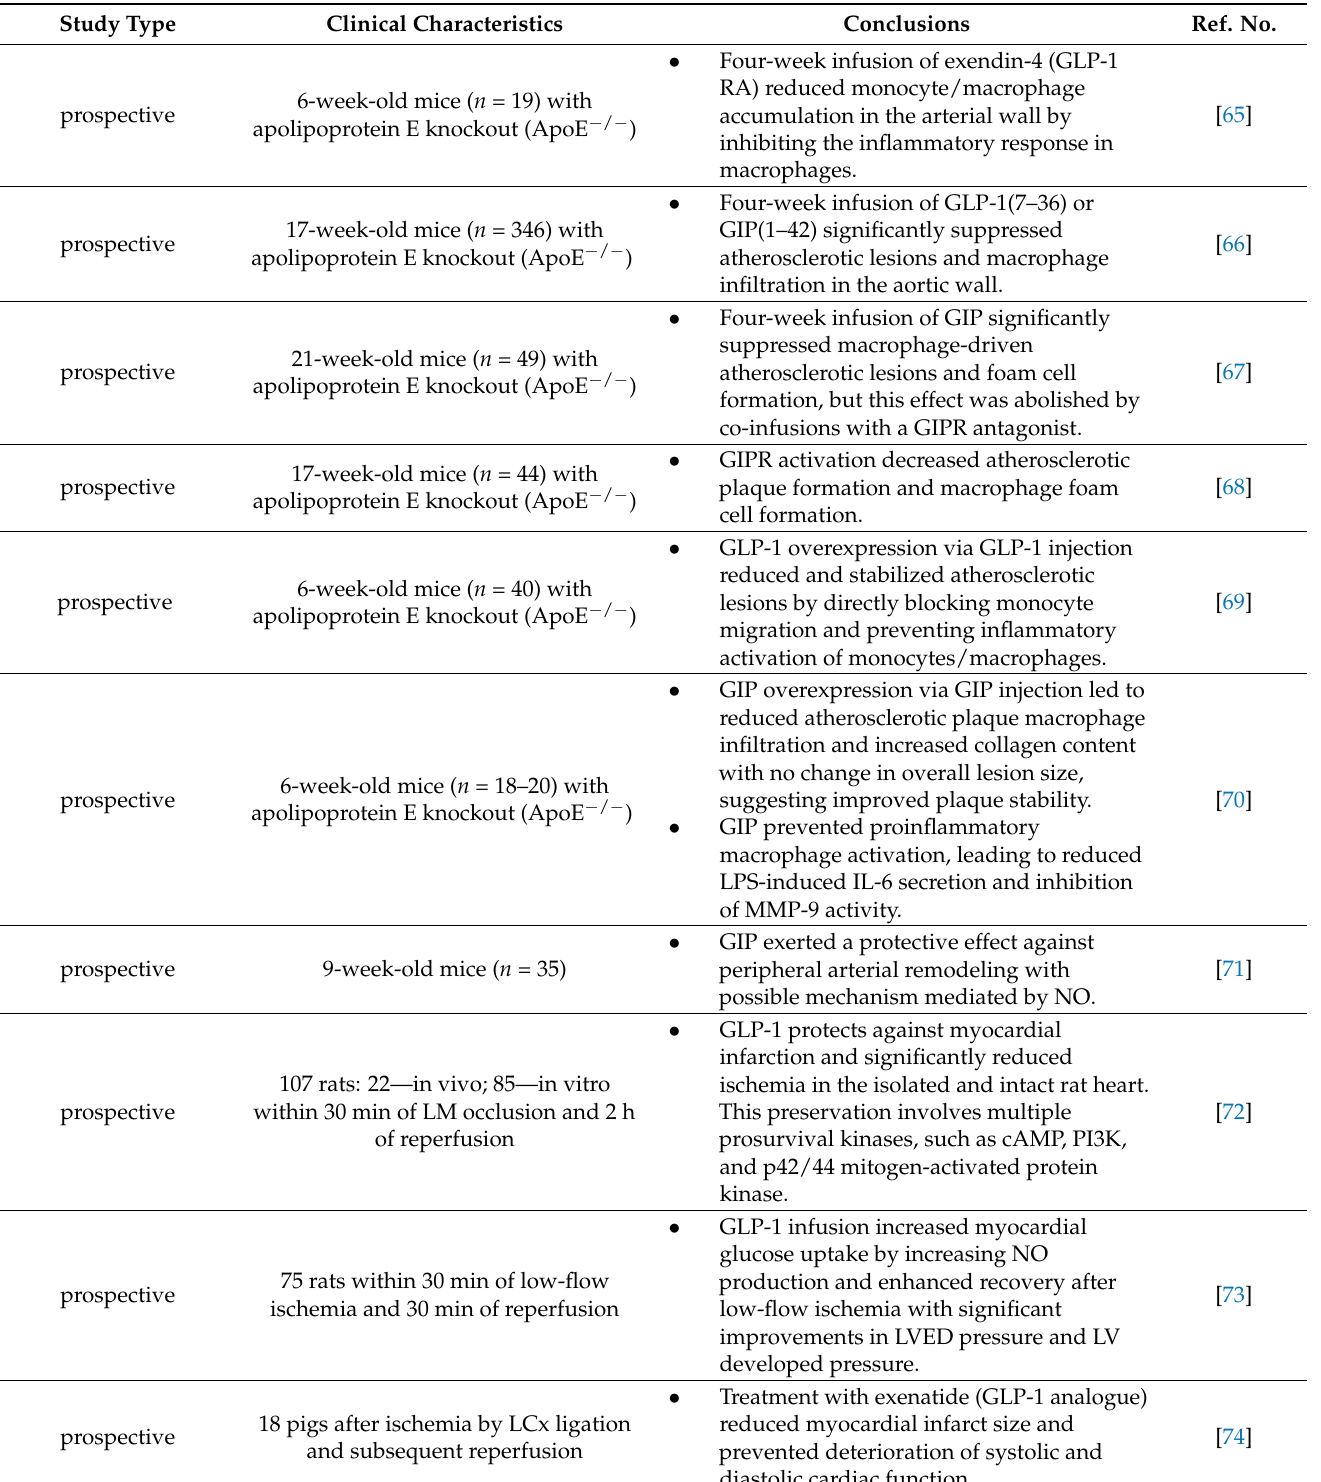
Table 1. Animal studies evaluating the role of GIP and GLP-1 in atherosclerosis and myocardial